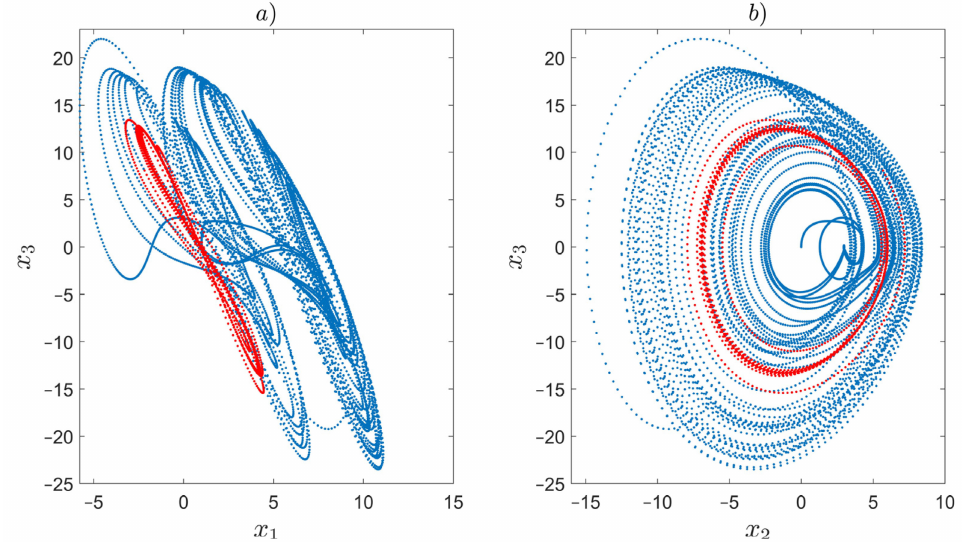
Figure 4. ( a ) A 2D projection of the state–space trajectories presented in Figure 3a on ( x 1 , x 3 ) plane; ( b ) a 2D projection of the state–space trajectories presented in Figure 3a on ( x 2 , x 3 )